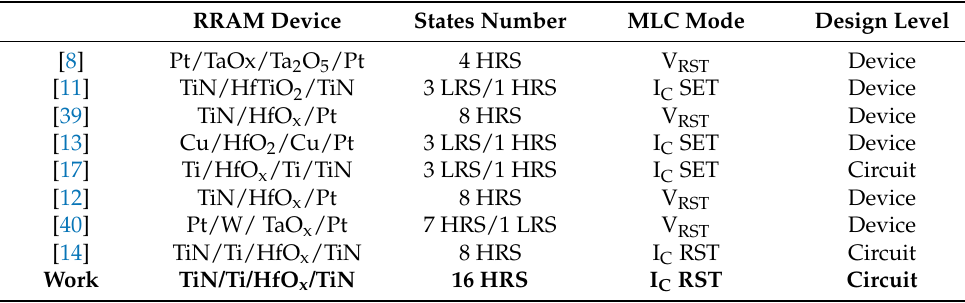
Table 4. State-of-the-art of MLC Table 4. Projections beyond quad-level cell.